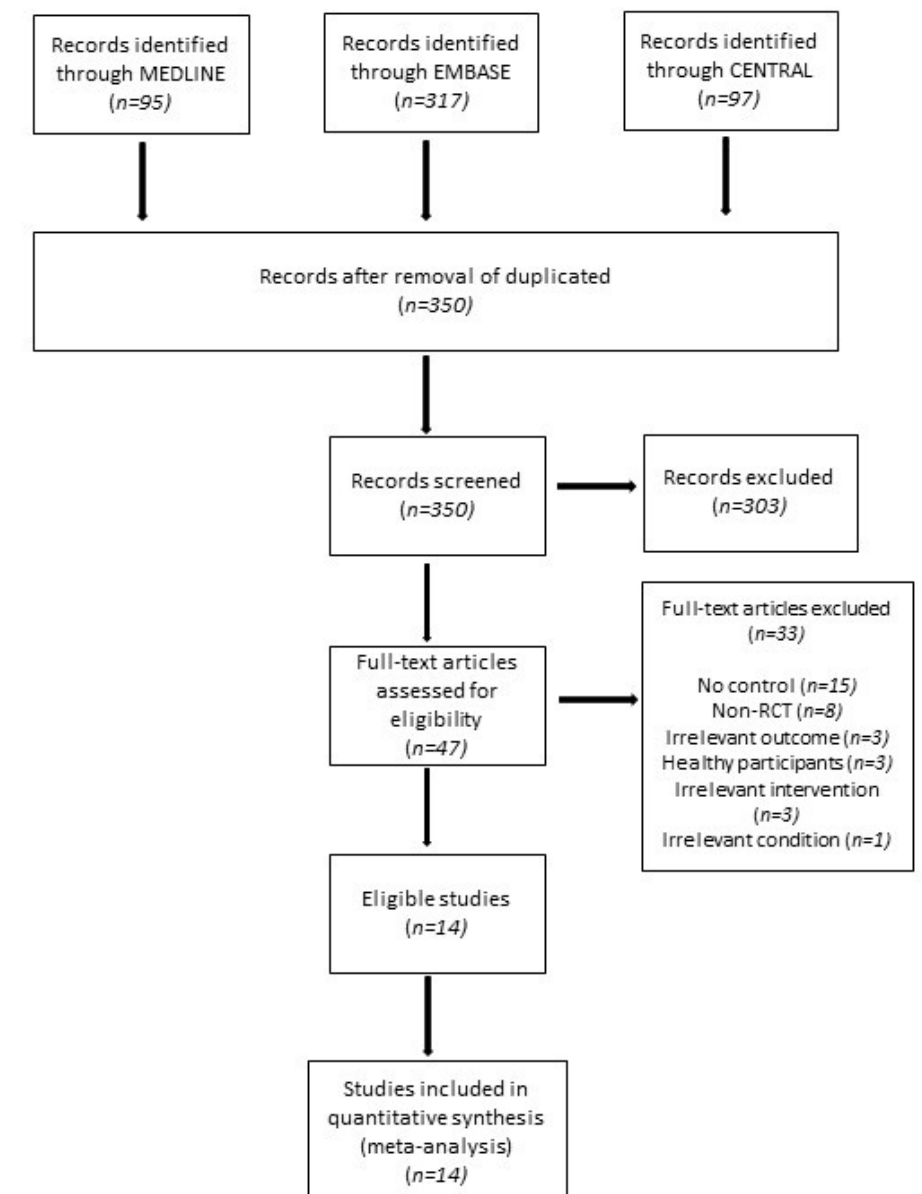
Figure 1. PRISMA flowchart illustrating the study screening and selecting process.